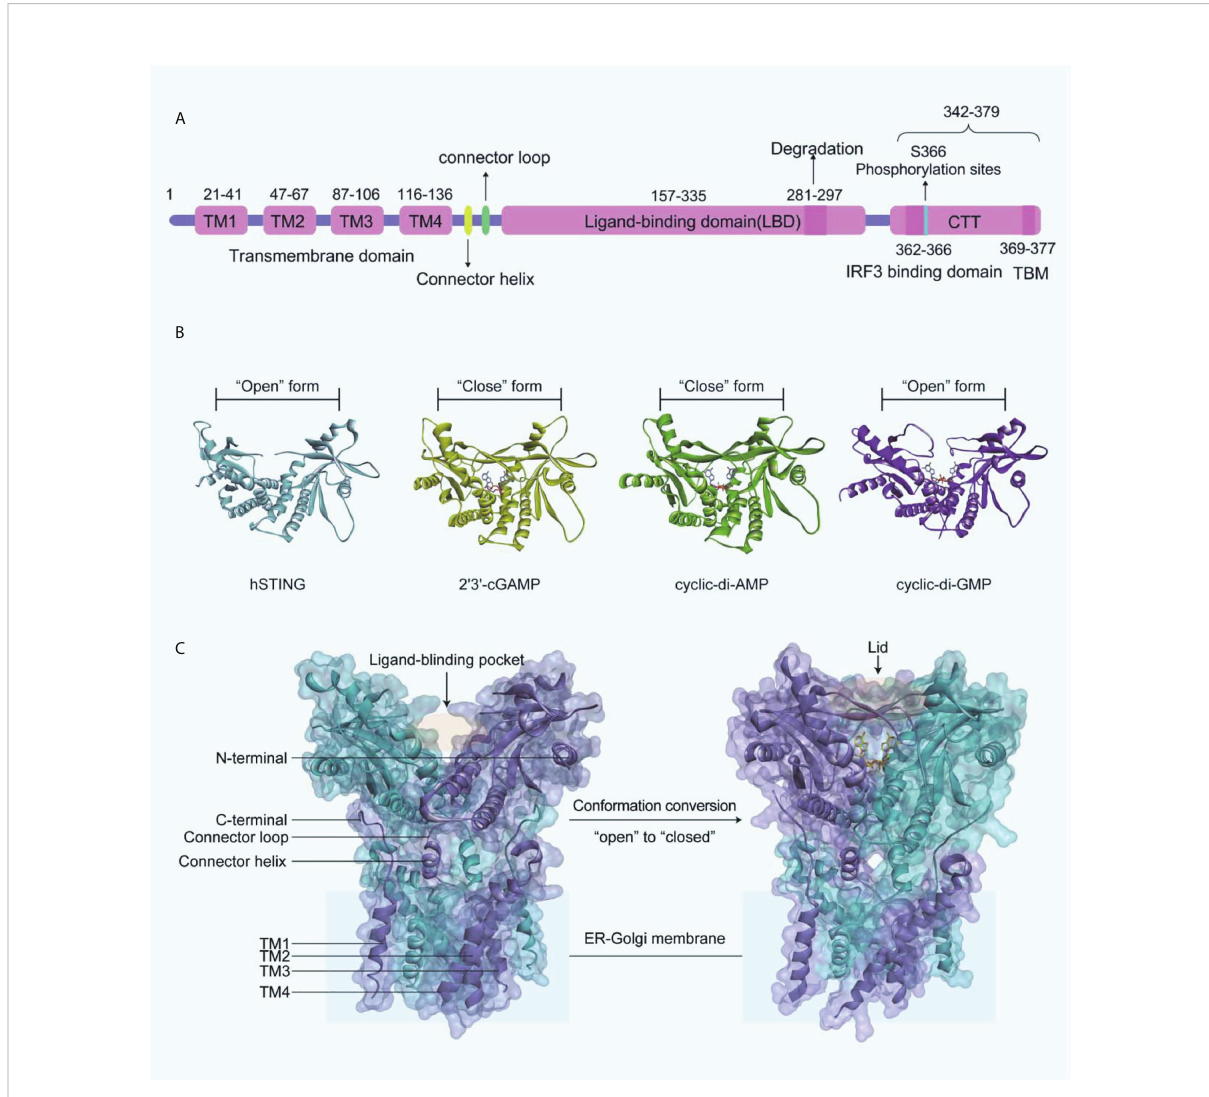
FIGURE 3 (A) Schematic organization of the structural domain of human STING; (B) Crystal structures of human STING CTD (blue ribbon, apo-STING, PDB-ID: 4EMU; yellow ribbon, STING bound 2 ’ 3 ’ -GAMP, PDB-ID: 4LOH; green ribbon, STING bound CDA, PDB-ID: 4F5D; purple ribbon, STING bound CDG, PDB-ID: 4F5Y); (C) On the left is the crystal structure of full-length human STING in open conformation (PDB-ID: 6NT5), and on the right is the crystal structure of chicken STING and 2 ’ 3 ’ -cGAMP in closed conformation (PDB-ID: